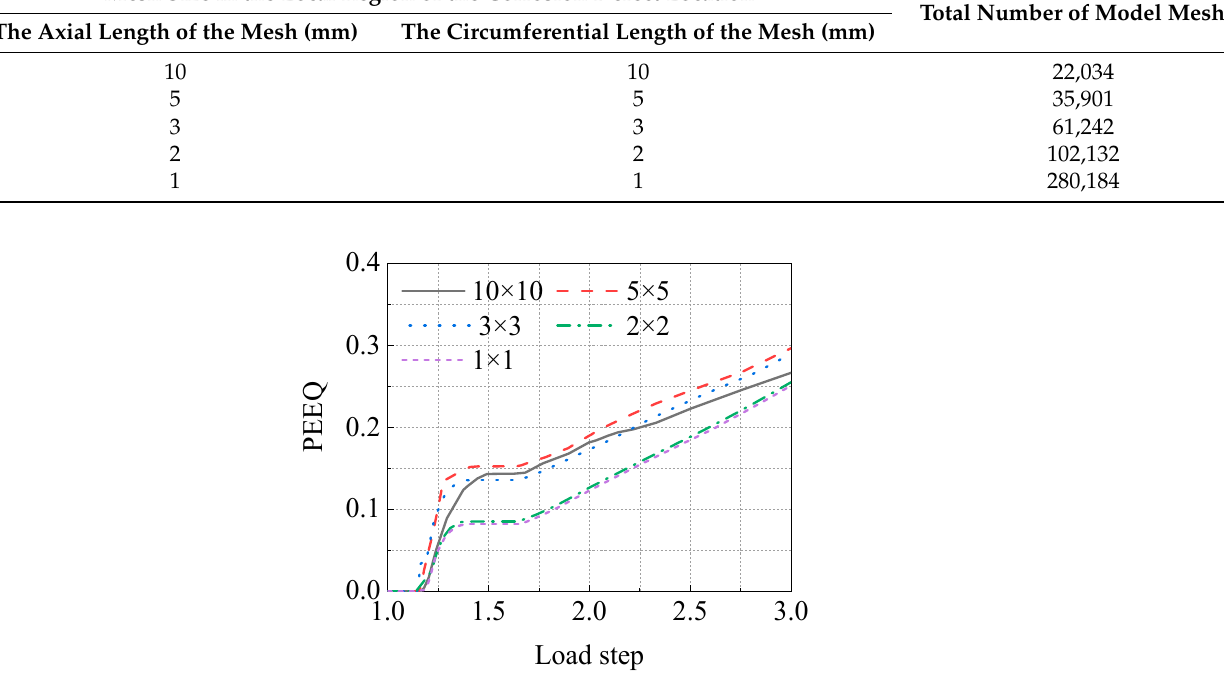
C l Figure 12. Boundary condition and mesh generation. In order to ensure the accuracy and reliability of the FEM calculation results and im-